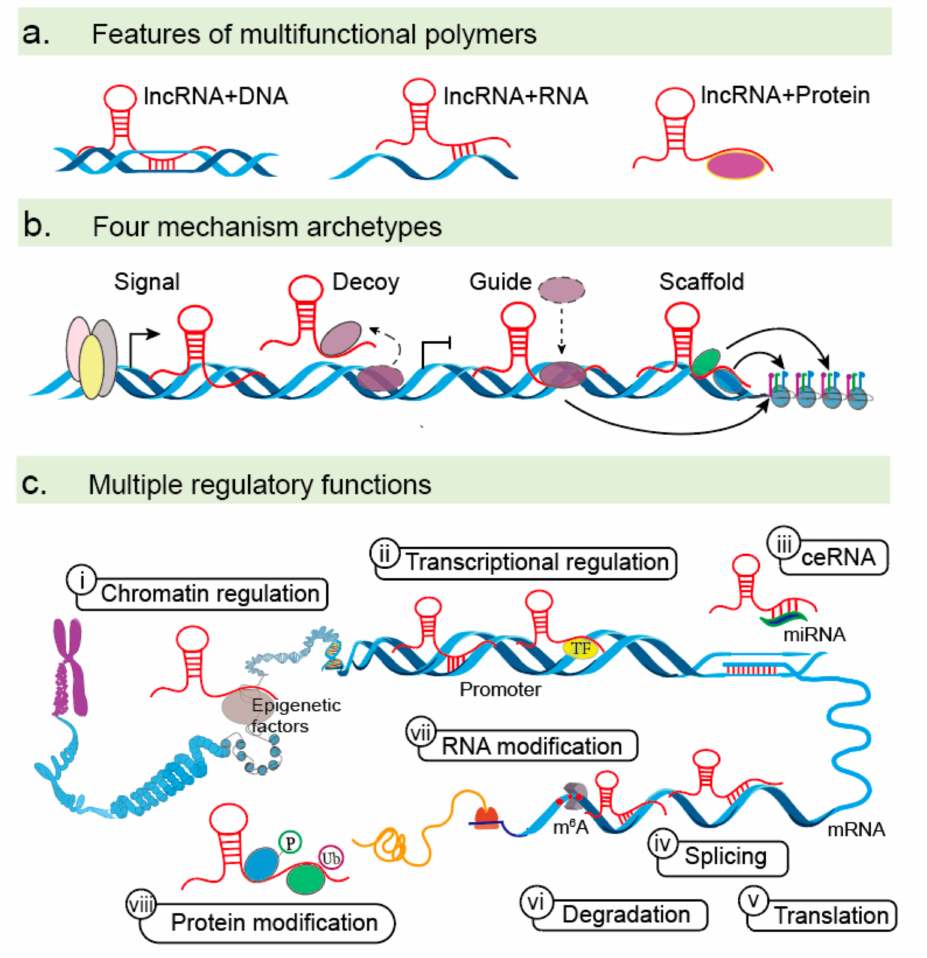
Figure 1. LncRNA functions. ( a ) lncRNAs can bind DNA, RNA, and protein molecules to regulate gene expression at multiple levels via base pairing or secondary structure formation. ( b ) LncRNAs have four primary roles as signals, decoys, guides, and sca ff olds. ( c ) Mechanism of action for lncRNAs in the nucleus ( i–ii ) and cytoplasm ( iii–viii ). ( i ) LncRNAs can recruit epigenetic factors to change patterns of chromatin organization, ( ii ) activate or repress the transcription of certain genes by interacting with DNA sequences or TFs, ( iii ) act as ceRNAs by base pairing with miRNA and diminishing its inhibitory e ff ects, and manipulate mRNA function by base pairing to ( iv ) regulate alternative splicing (e.g., MALAT 1), ( v ) a ff ect mRNA translation (e.g., TTN-AS1 and AC132217.4), and ( vi ) mRNA degradation (e.g., CASC11). ( vii–viii ) lncRNAs can modify mRNA and proteins, playing regulatory roles in methylation, phosphorylation, and